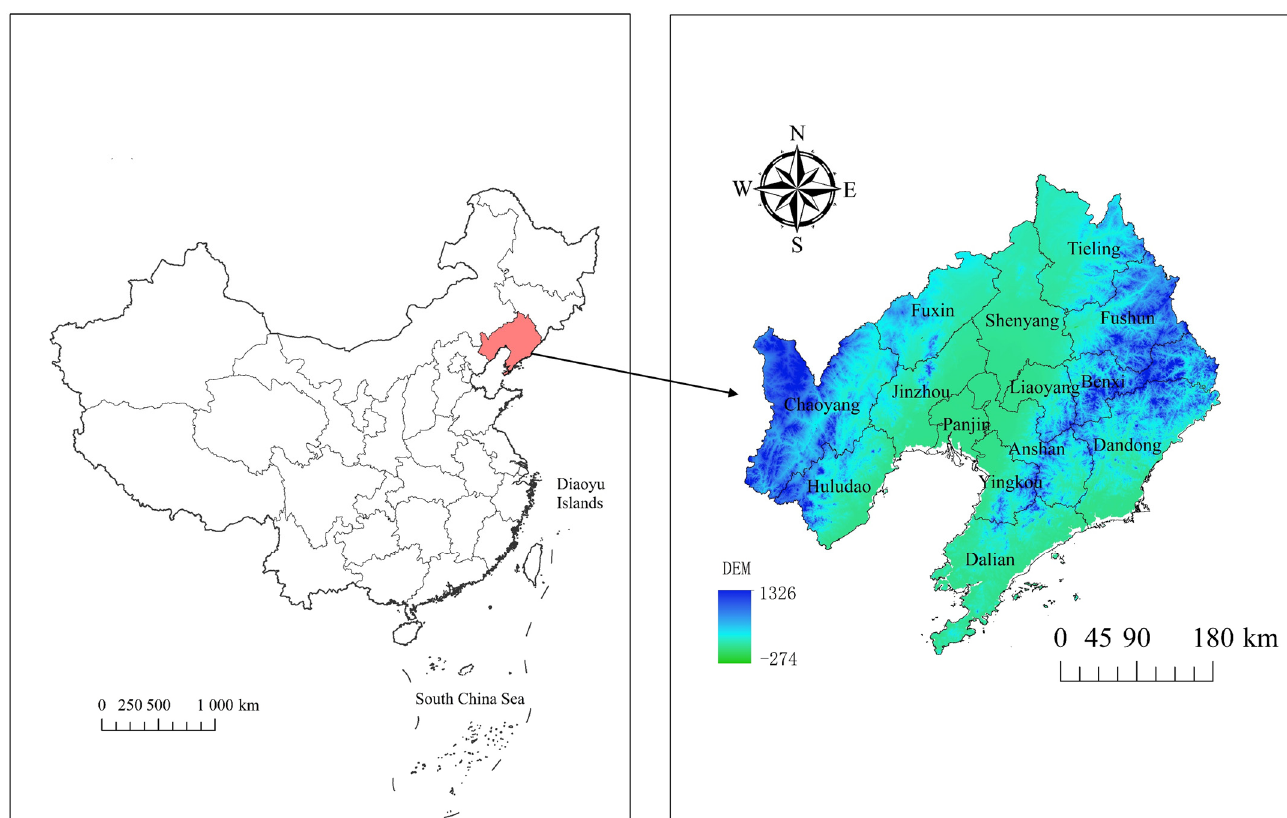
Figure 2. Location of the study area.